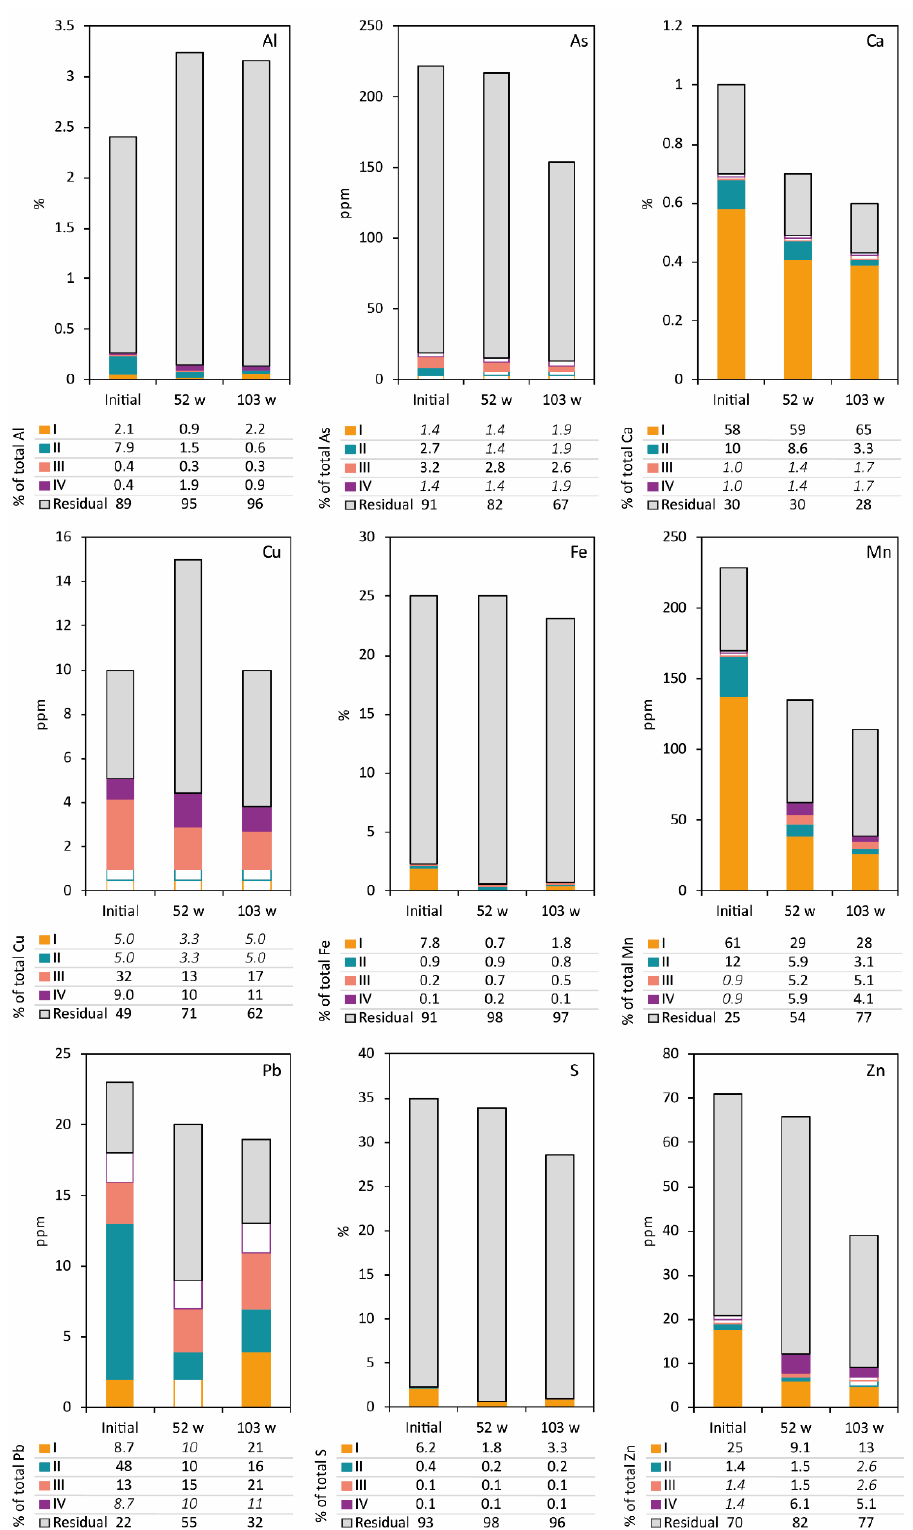
Figure 3. Extracted element content in the waste rock before leaching (initial) and on separate occasions at year one and two (weeks 52 and 103), modified from Nyström et al. [5]. Steps I–IV in sequential extractions after Dold (2003). Water-soluble fraction ( I ), exchangeable fraction ( II ), Fe(III)oxyhydroxides ( III ), and Fe(III)oxides ( IV ). Content below the detection limit is only outlined. The residual fraction (e.g., primary silicates and sulfides) is calculated as the difference between the whole rock element content of the sample (NaOH fusion) and the sum of steps